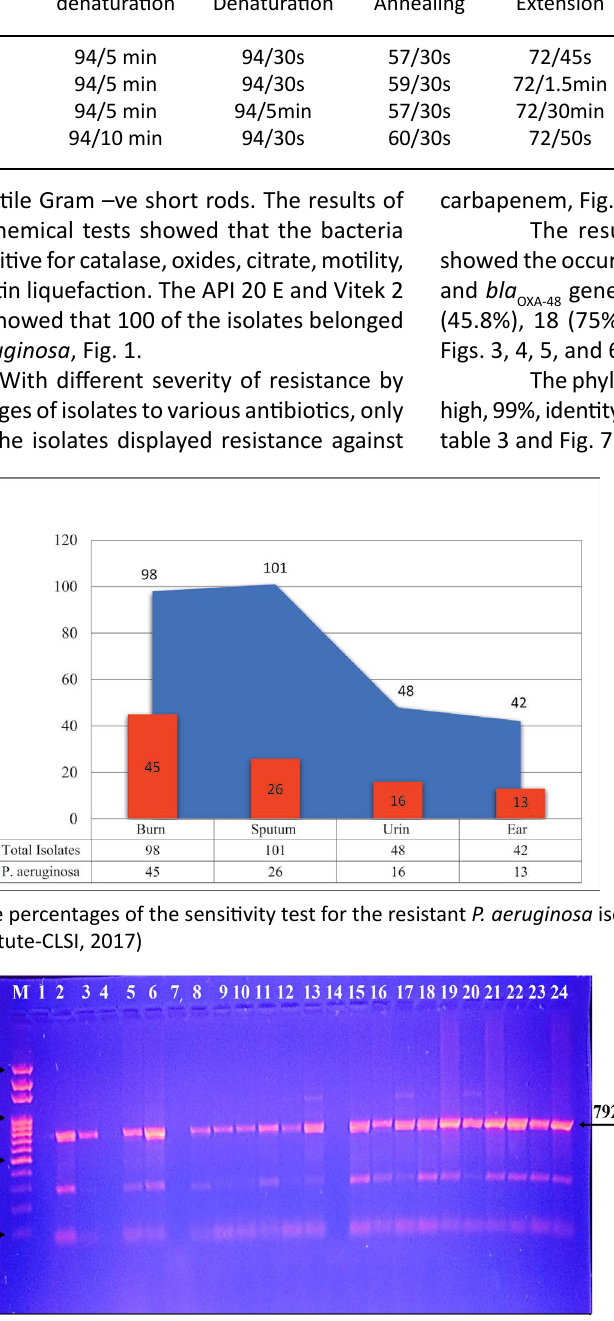
gene the resistant P. aeruginosa isolates to carbapenem. M: ladder, GES